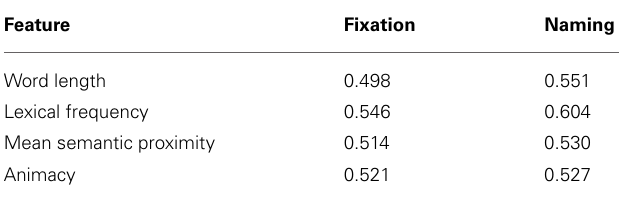
Table 6 | AUC scores for linguistic features.